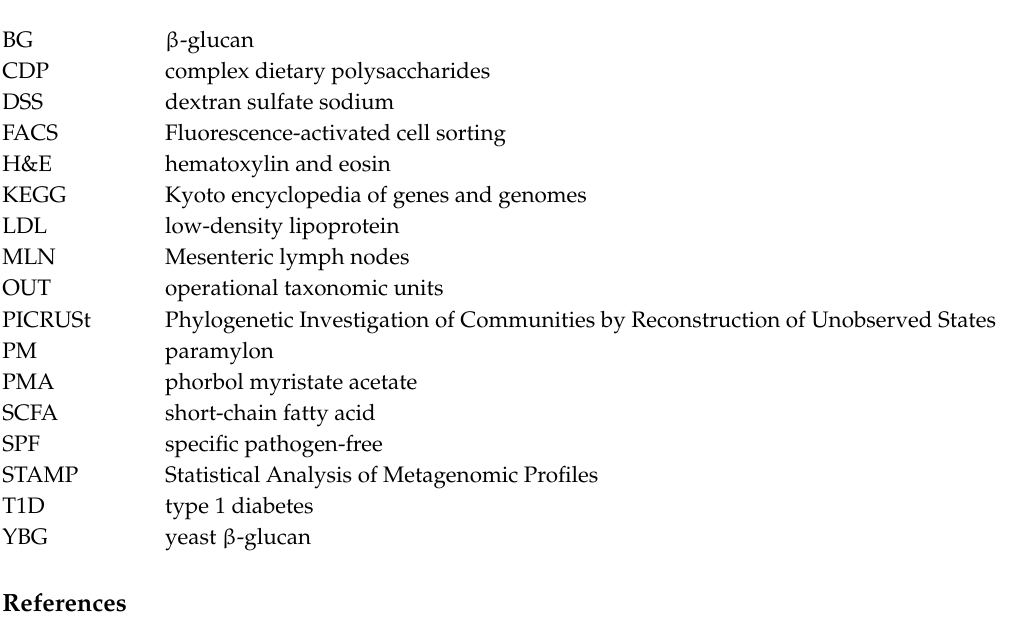
determined for fecal samples collected from control and PM treated mice of day 30 (A) and day 45 (B) employing STAMP, Figure S6: Di ff erences in the prevalence of specific functions at the 2nd levels of functional hierarchy were examined in control mice between days 0 and 45 (A) and PM treated mice between days 0 and 30 (B) and days 0 and 45 (C) employing STAMP, Figure S7: Taxa contributing toward the function of fructose and mannose metabolism at day 45 in control and PM treated mice, analyzed employing the Local Mapper tool in iVikodak, Figure S8: Taxa contributing toward the function of glycosaminoglycan degradation at day 45 in control and PM treated mice, analyzed employing the Local Mapper tool in iVikodak, Figure S9: Taxa contributing toward the function of fatty acid biosynthesis at day 45 in control and PM treated mice, analyzed using the Local Mapper tool in